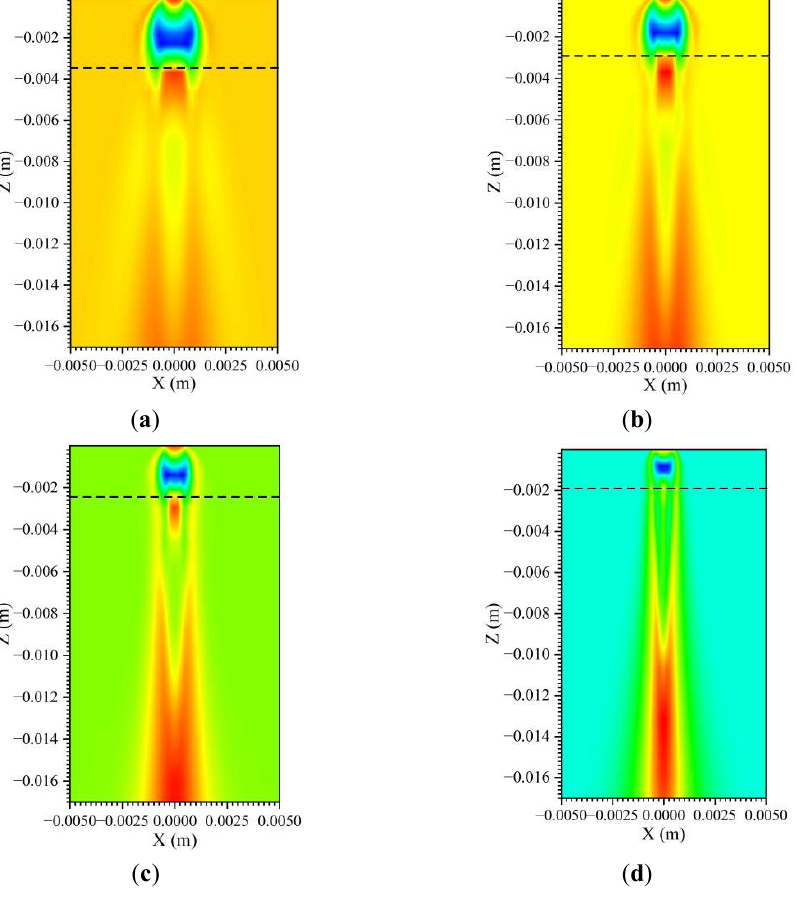
Figure 12. Variations in the Mach disk distance and circumferential diameter in the near-field flow area under different leakage pressures: ( a ) 2; ( b ) 1.5; ( c ) 1; ( d ) 0.5 MPa.